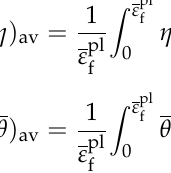
Figure 9. Finite element mesh models: ( a ) CH6; ( b ) FS; ( c ) NRB1; ( d ) NRB3; ( e ) NRB5.